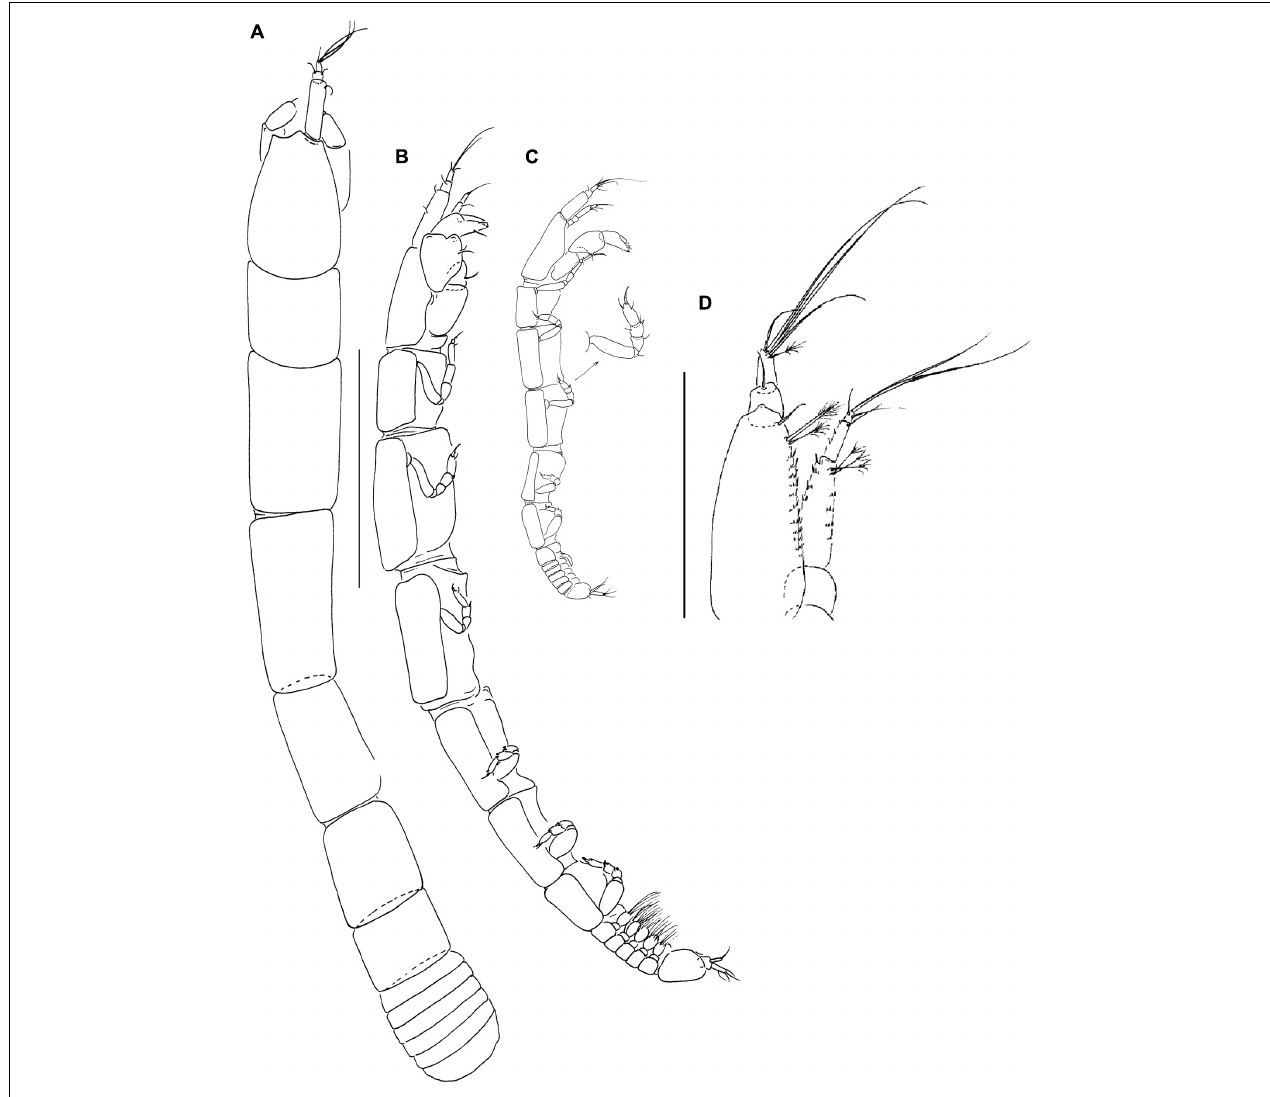
FIGURE 13 | Yarutanais sima (Bła˙zewicz-Paszkowycz and Bamber, 2012) (A,B) neuter (J69711); (C) manca-3; (D) antennule (J58902). Scale: panels (A–C) = 1 mm, panel (D) = 0.1 mm.